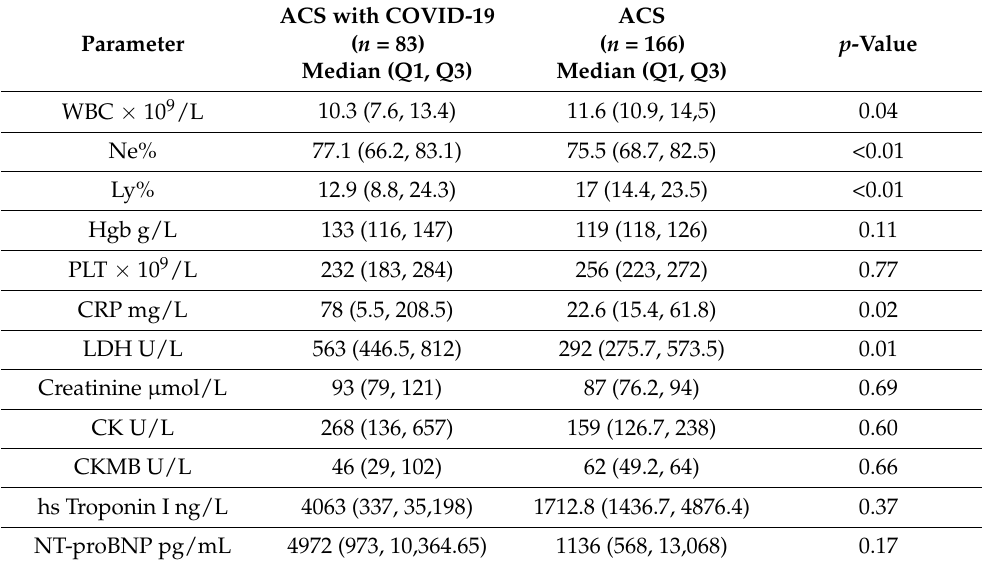
Table 3. Laboratory findings at admission to